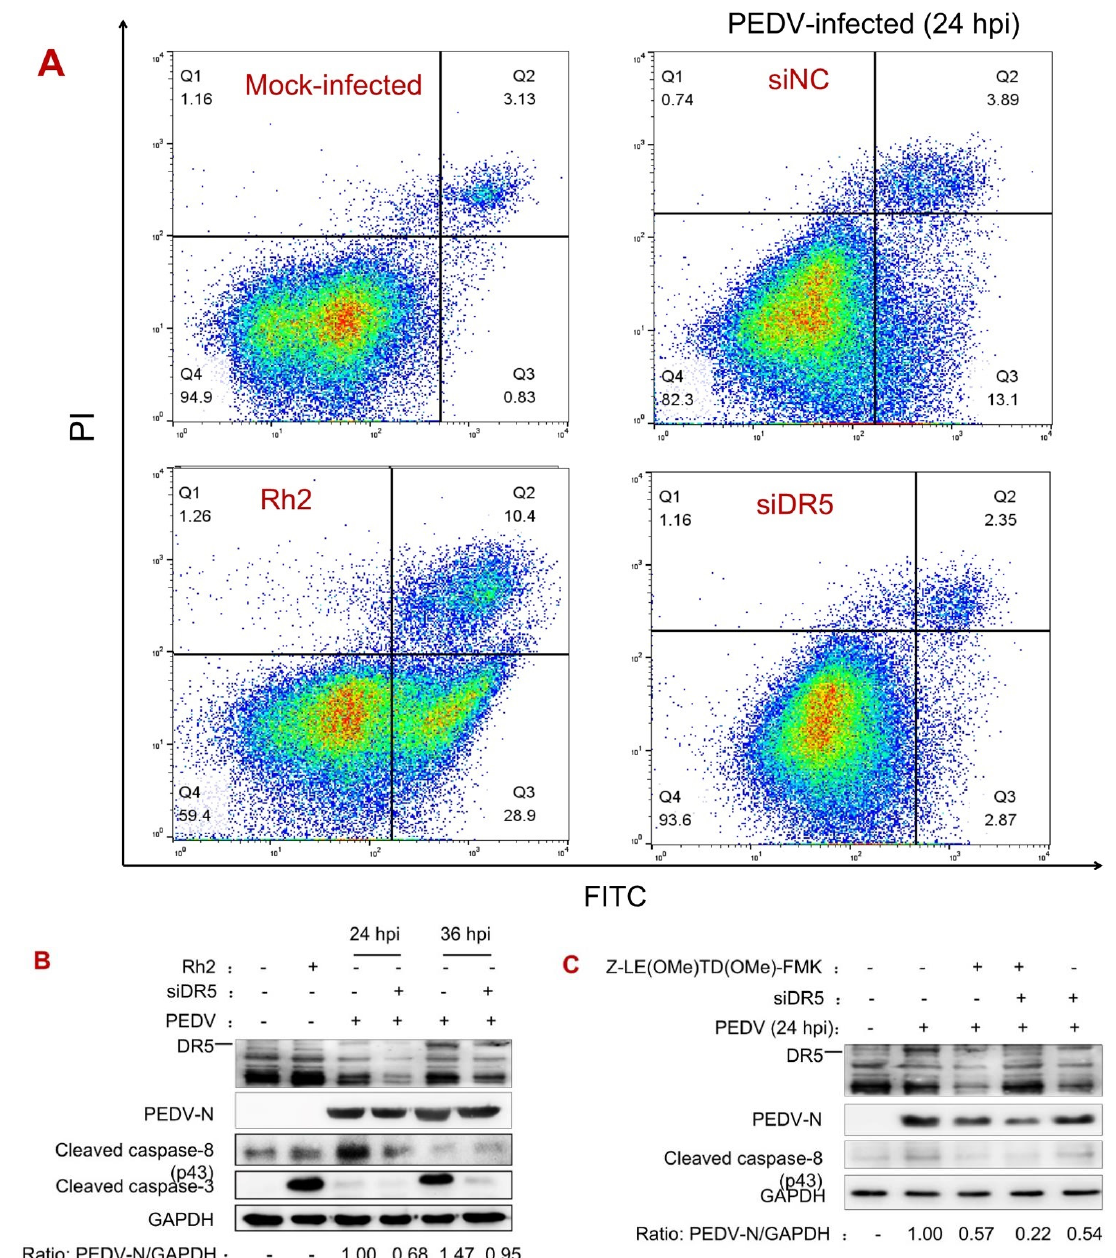
Figure 3. DR5 is associated with caspase-8-dependent apoptosis in PEDV-infected Vero cells. ( A ), Cell apoptosis was analyzed by flow cytometry with dual AnnexinV-PI cell labeling. Vero cells were transfected with siDR5 or siNC for 24 h, and then mock infected or infected with PEDV at MOI of 0.1. At 24 hpi, cells were collected and dual-labeled with AnnexinV and PI and analyzed by FACS. Lower left quadrants represent intact cells; lower right quadrants represent early apoptotic cells; upper right quadrants indicate late apoptotic cells; upper left quadrants indicate necrotic cells. Figure representative of three independent experiments. Graph on the right represents the percentage of apoptotic cells. As positive control, cells were pretreated with Ginsenoside Rh2 (in- ducer of apoptosis) at a concentration of 100 μM for 1 h. ( B , C ), Vero cells were transfected with siDR5 or siNC for 24 h, and then mock infected or infected with PEDV at MOI of 0.1, in the pres- ence of Ginsenoside Rh2 (inducer of apoptosis) ( B ), Z-LE(OMe)TD(OMe)-FMK (0.1 μM), or DMSO (0.1%) ( C ). At pointed time, cells were harvested and the protein level was analyzed by Western blot with the indicated antibodies. Note: cells were pretreated with Ginsenoside Rh2 for 1 h. In addition, Vero cells were infected with PEDV at MOI of 0.1 at the presence of Z-LE(OMe)TD(OMe)-FMK (0.1 μM), a selective inhibitor of caspase-8 [34]. We found that Z-LE(OMe)TD(OMe)-FMK reduces the protein level of PEDV-N, which showed that caspase-8-dependent apoptosis is important to the replication of PEDV (Figure 3C). In- terestingly, the effects of DR5 knockdown and Z-LE(OMe)TD(OMe)-FMK treatment on the reduction in the PEDV infection were superimposed, which revealed that DR5 might have an additional function (Figure 3C). Our results suggest that DR5 facilitates PEDV replication by contributing to the activation of the death receptor pathway. 3.4. DR5 Promoted the Early Entry of PEDV Considering that the level of DR5 protein, a membrane protein, was increased at 1 h post-infection (Figure 2A,B), we studied whether DR5 influences the viral entry of PEDV. Vero cells transfected with siDR5 or siNC were infected with PEDV at 37 °C for 2 h to allow viral entry. We found that the knockdown of DR5 significantly reduced PEDV en- try (Figure 4A). In addition, siRNA efficiency was assessed as shown in Figure 4B. To determine the stage of viral entry in which DR5 plays a role, cells were treated with E64D (0.1 μM, a cysteine protease inhibitor) 1h before viral infection. The results showed that E64D reduced PEDV entry, and importantly, it showed further inhibition after DR5 knockdown (Figure 4C,D). Our findings suggest that DR5 enhances early entry of PEDV.